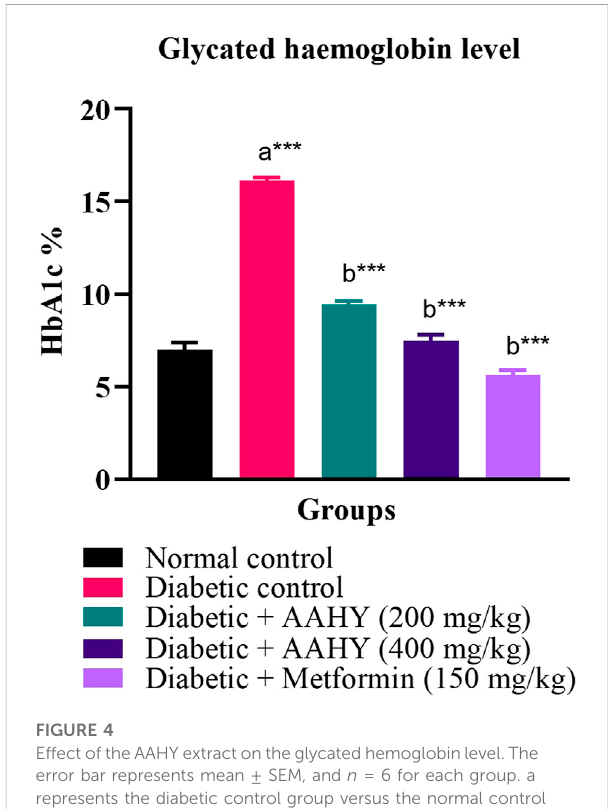
FIGURE 4 Effect of theAAHYextract on theglycated hemoglobinlevel.The error bar represents mean ± SEM, and n = 6 for each group. a represents the diabetic control group versus the normal control group,andbrepresentsthediabeticcontrolgroupversustreated groups. * p < 0.05, ** p < 0.01, and *** p < 0.001. SEM: standard error of